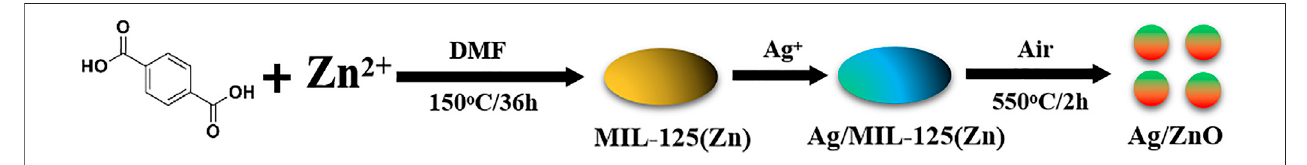
FIGURE 1 | Synthetic procedure for the Ag/ZnO photocatalyst.